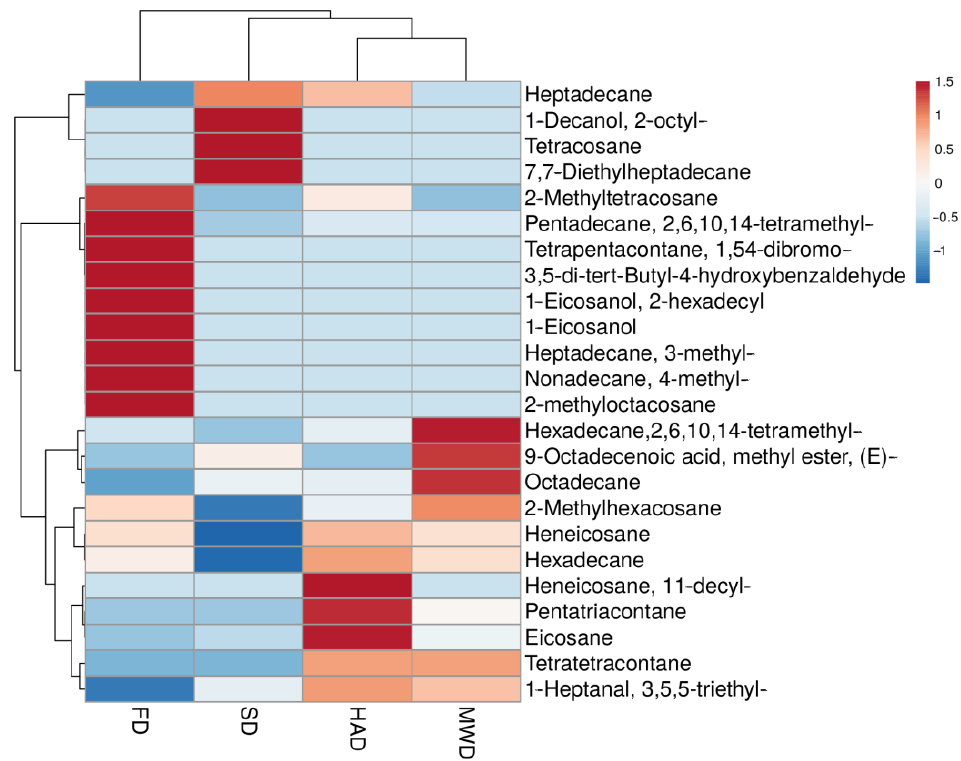
Figure 8. Heat map alkanes, fatty alcohols, and aldehydes of lipophilic extract of Pleurotus ostreatus powder lipophilic extracts. FD—freeze drying; HAD—hot air drying; MWD—microwave drying; SD—sun drying. The increase and decrease in the content of substances are shown in red and blue, respectively.